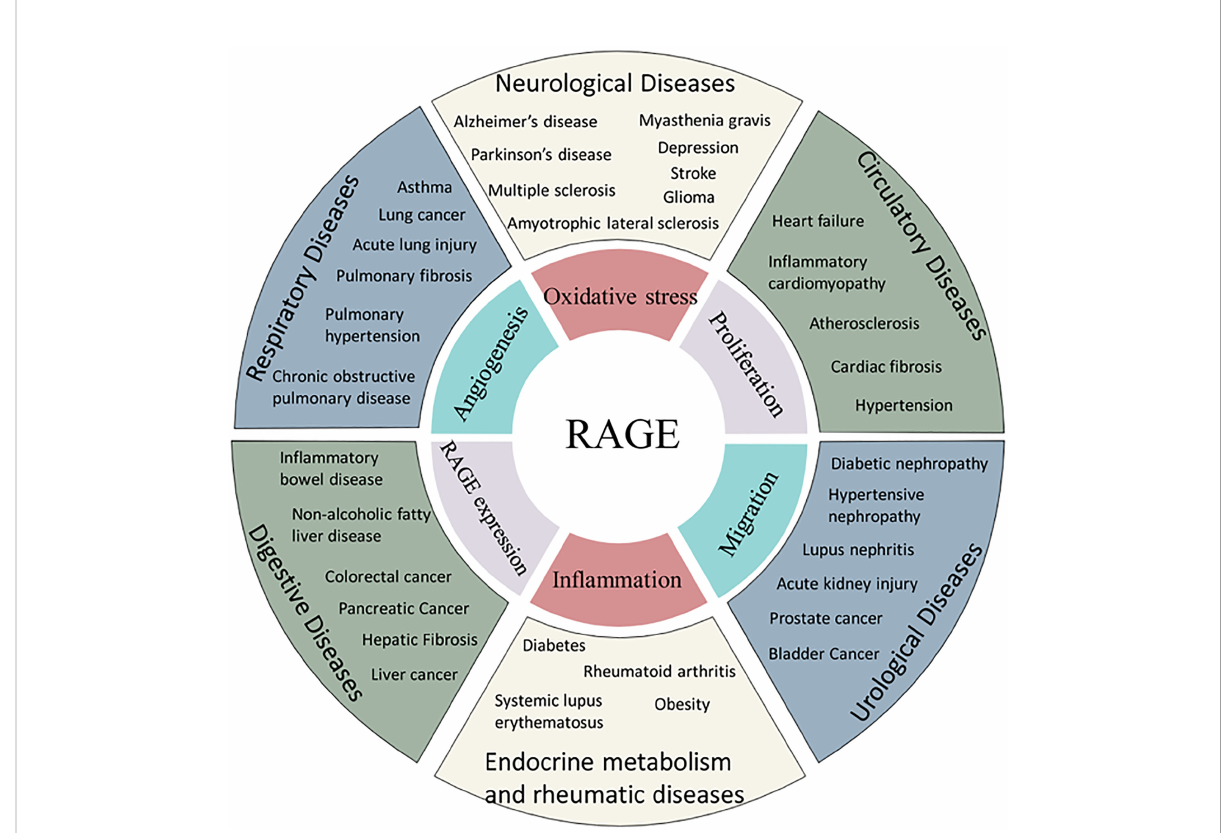
FIGURE 2 Association of RAGE and human diseases. AGEs are related to the incidence of several diseases through common mechanism of oxidative stress, angiogenesis, proliferation, in fl ammation or